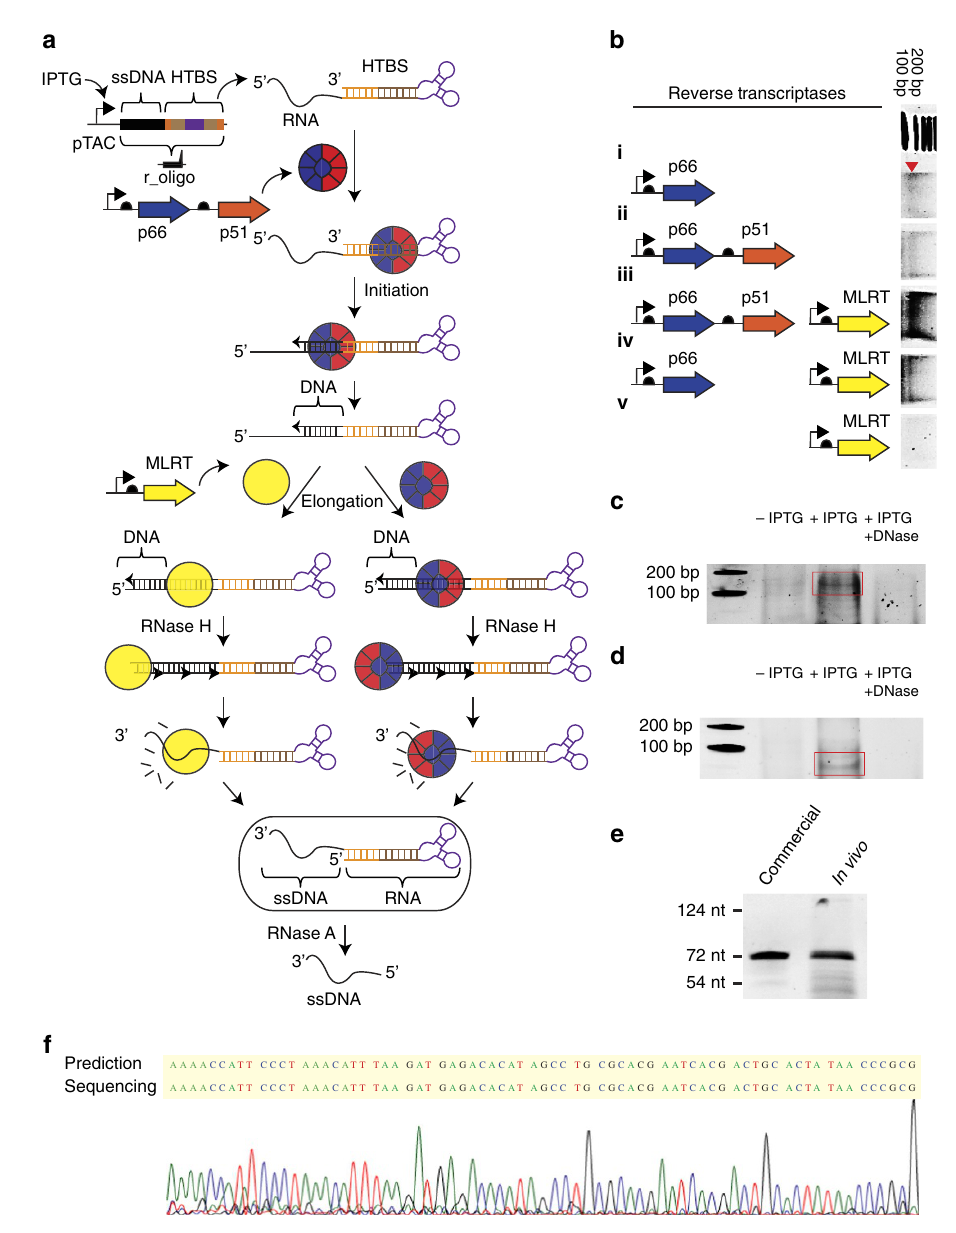
Figure 2 | In vivo production of ssDNA. ( a ) Schematic for the conversion of the r_oligo gene to ssDNA. The r_oligo gene contains both the desired ssDNA sequence and the HTBS part, which serves as a terminator (black, ssDNA sequence; orange, A/U region; brown, PBS; purple, hairpin). ( b ) The impact of different combinations of RT expression on ssDNA production is shown. Data are shown for the production of a 205-nt ssDNA (r_oligo_205) under purification conditions preventing the removal of the HTBS (RNAse A þ 150mM NaCl). The red triangle shows the predicted location of the band (note that the ladder is based on double stranded DNA). The bands are from the same gel and the image processed once, but the order changed for publication. For the full gel in its original order, see Supplementary Fig. 1. The ssDNA sequence and reverse transcriptase sequences are added in Supplementary Tables 2 and 3. ( c ) The expression of ssDNA after 18h growth in the presence ( þ IPTG, 1mM) and absence of IPTG ( (cid:2) IPTG) under conditions preserving the HTBS. To confirm that the band is ssDNA, the same sample is exposed to DNase ( þ IPTG/ þ DNase, 1mM/4 units). ( d ) For the same system as in c , the ssDNA is treated to remove the HTBS RNA (RNAse and no salt). ( e ) Comparison of an in vivo produced ssDNA with commercial chemically synthesized ssDNAs. The ladder was calculated using commercial oligos of defined size run simultaneously in the gel. The ssDNA sequence is in Supplementary Table 2. ( f ) Sequencing analysis of the in vivo produced 72-mer. The ‘prediction’ is the complementary sequence of the expected ssDNA